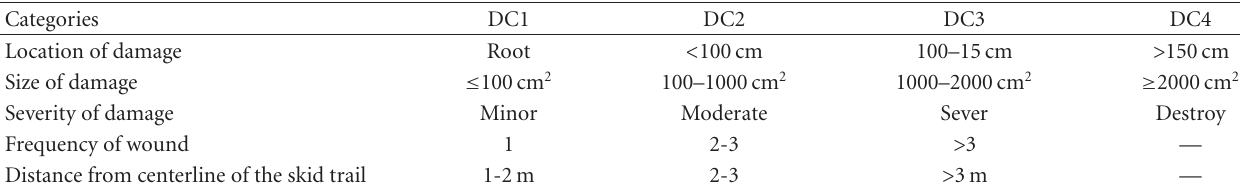
Table 2: Classification of damage, by location, size, severity, frequency, and distance from centerline of the skid trail imposed by logging